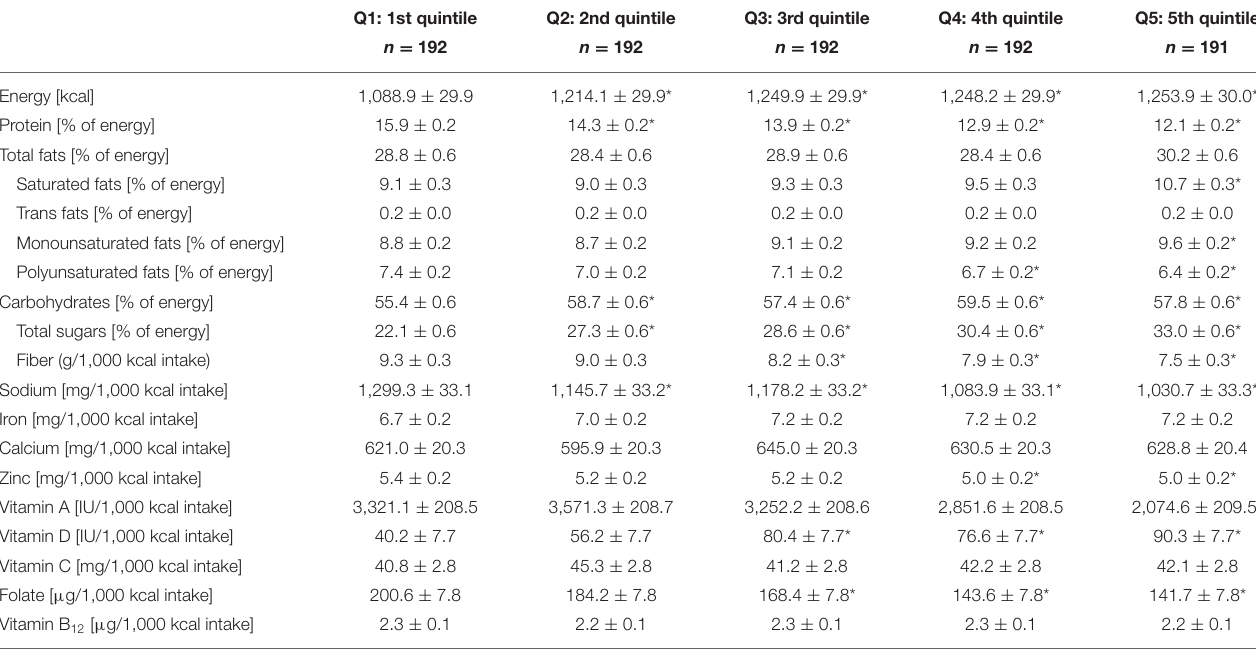
TABLE 4 | Intake of energy, nutrients of concern, and nutrients for promotion by dietary contribution of UPF in the diet of the Food Environment Chilean Cohort ( n = 959). Q1: 1st quintile Q2: 2nd quintile Q3: 3rd quintile Q4: 4th quintile Q5: 5th quintile n = 192 n = 192 n = 192 n = 192 n =